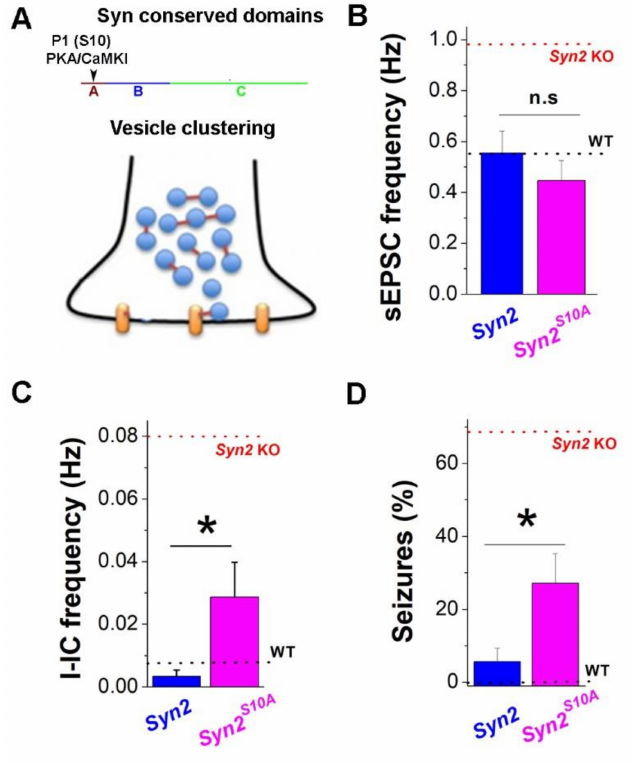
Figure 6. Phosho-incompetent Syn2 S10A mutant partially rescues the overexcitable phenotype in Syn2 KO animals. ( A ) A diagram showing the conserved domains ( A – C ) of Syn II and the PKA/CaMKI phosphorylation site P1 in the A domain. The diagram below illustrates Syn II (red) function in tethering and clustering of synaptic vesicles and directing them to Ca 2+ channels (yellow). ( B ) ICV of the native Syn2 and mutant Syn2 S10A genes produce a similar reduction in spontaneous synaptic activity ( n = 16). ( C ) Expression of mutant Syn2 S10A does not reduce the 4-AP produced epileptiform activity to the extent observed for the expression of native Syn2 ( p < 0.05, n = 9). ( D ) Expression of mutant Syn2 S10A does not reduce seizure activity to the extent observed for the expression of native Syn2 (* p < 0.05, n = 9). Dotted red lines corrrespond to Syn2 KO animals, and dotted black lines correspond to WT animals (replotted from Figures